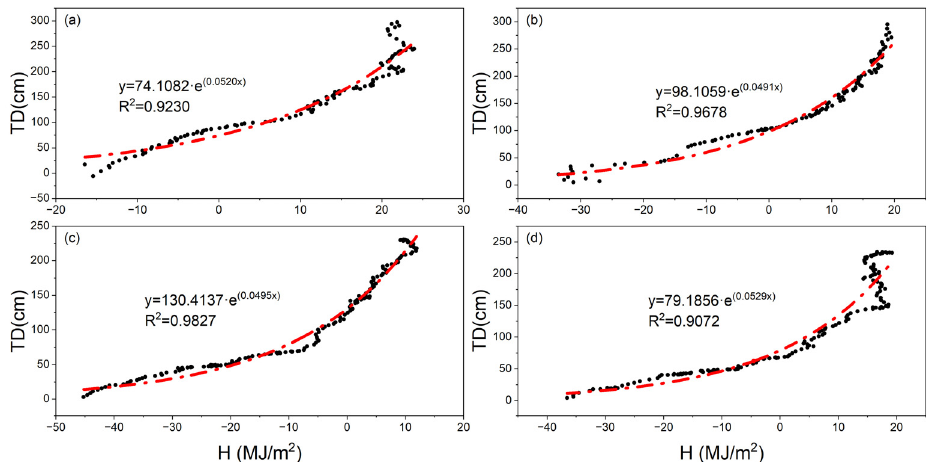
Figure 7. The effect of soil enthalpy upon the thawing depth ( TD ) of the active layer ( p < 0.05), ( a , b ) TGL site in 2006 and 2007, ( c , d ) BLH site in 2009 and